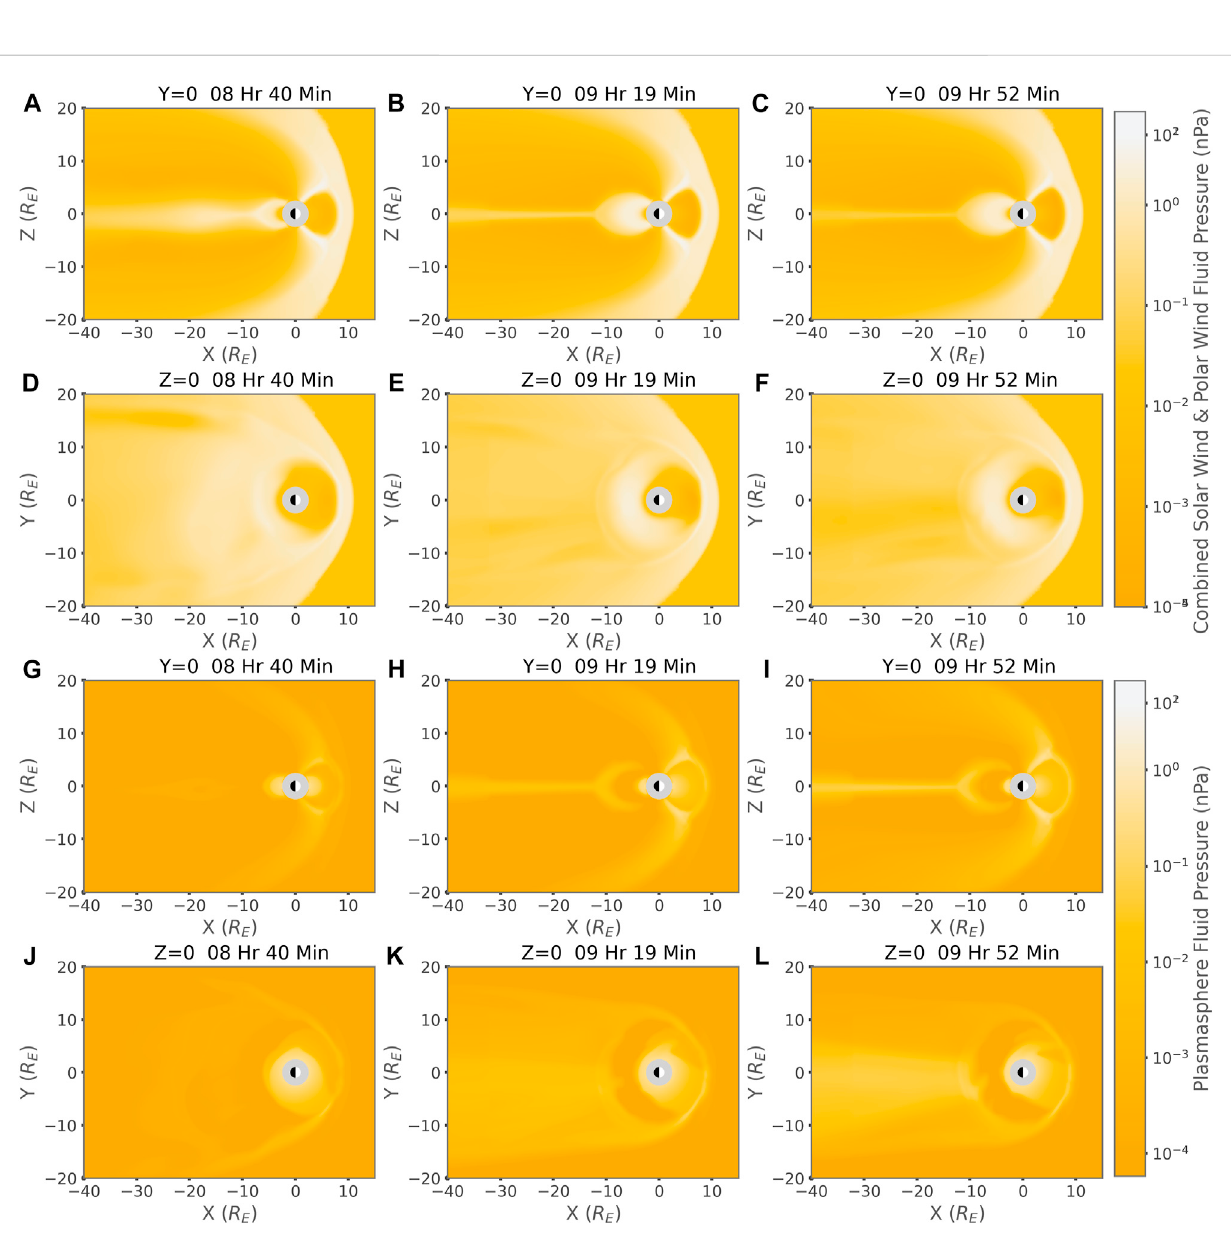
FIGURE 4 Pressure of Fluids in BATS-R-US for the Ideal Square Wave event. Column (A) : 8 Hr and 40 Min into the simulation. Column (B) : 9 Hr 19 Min into the simulation. Column (C) : 9 Hr 52 Min into the simulation. (A – F) Pressure of the combined solar wind and ploar wind fl uid. (A – C) Y = 0 slices, (D – F) Z = 0 slices. (G – L) Pressure of the plasmasphere fl uid. (G – I) Y = 0 slices, (J – L) Z = 0